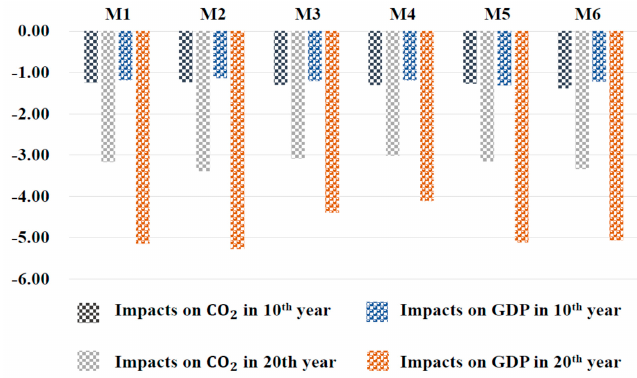
Figure 7. Impacts of the trading mechanism on China’s carbon emissions and GDP with different regional abatement rates under scenarios M1–M6 in 10th year and 20th year (%).